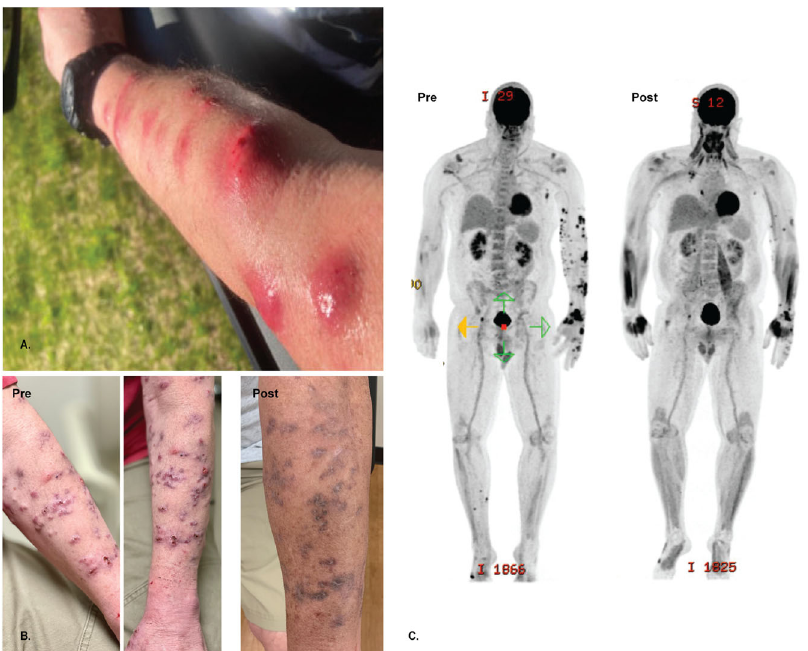
Fig. 1 Clinical course of M. chelonae infection. A Left upper extremity with multiple large erythematous, fl uctuant to nodular lesions ultimately diagnosed as disseminated cutaneous Mycobacterium chelonae infection. B Images of the left upper extremity lesions prior to (Dec 2020) and following (August 2021) addition of bacteriophage therapy. C PET/CT prior to (March 2021) and following (August 2021) addition of bacteriophage therapy.